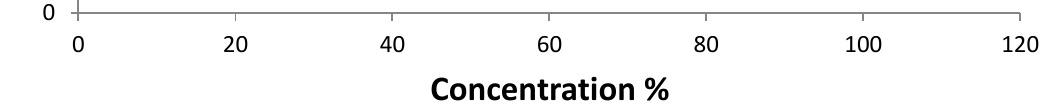
Figure 3. Relationship between percentage mitotic and root growth inhibitions at various concentrations of e-waste leachate.